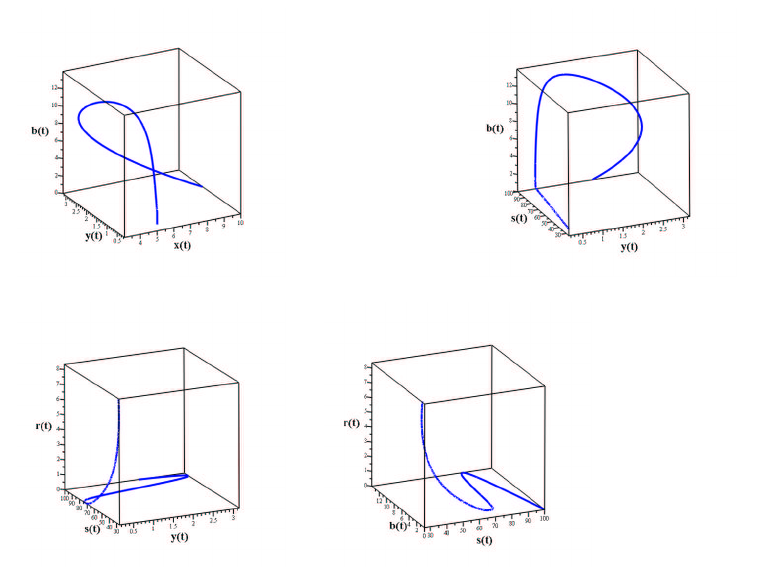
Figure 4: Phase portraits using 5-term MsDTM with r 0 = 1.06 and R 0 ≈ 7.1 .